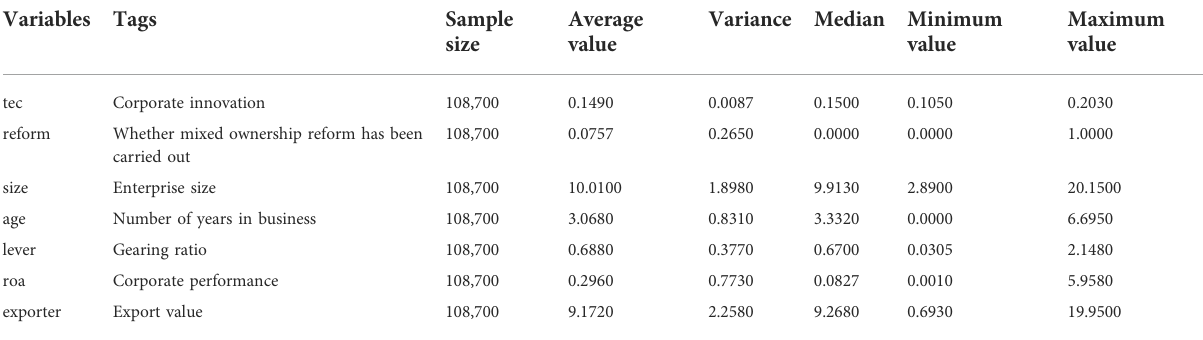
TABLE 2 Description of main variables and descriptive statistics (full sample).